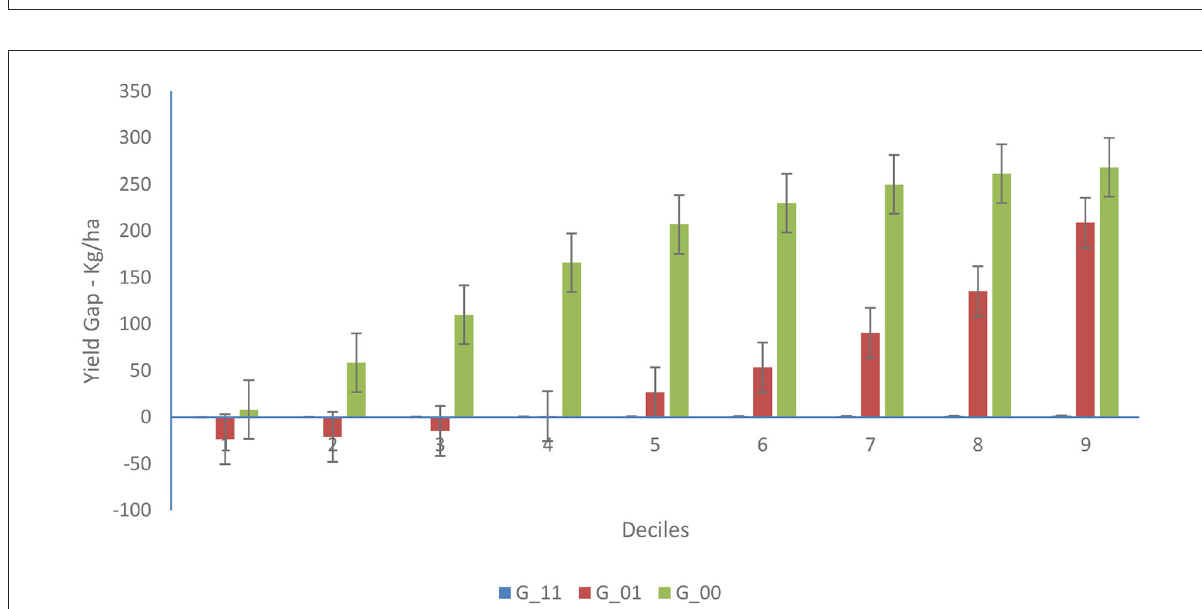
FIGURE3 Yield gap profile at the inefficiency frontier (Kg/Ha). Where G-11, G-00 and G-01 indicates mediated-adopters, non-mediated-non-adopters and mediated-non-adopters, respectively at the technical inefficiency function of yield. The figure illustrates the yield gap profile in deciles of farmers operating at different levels of technical inefficiency, compared to farmers operating at zero technical